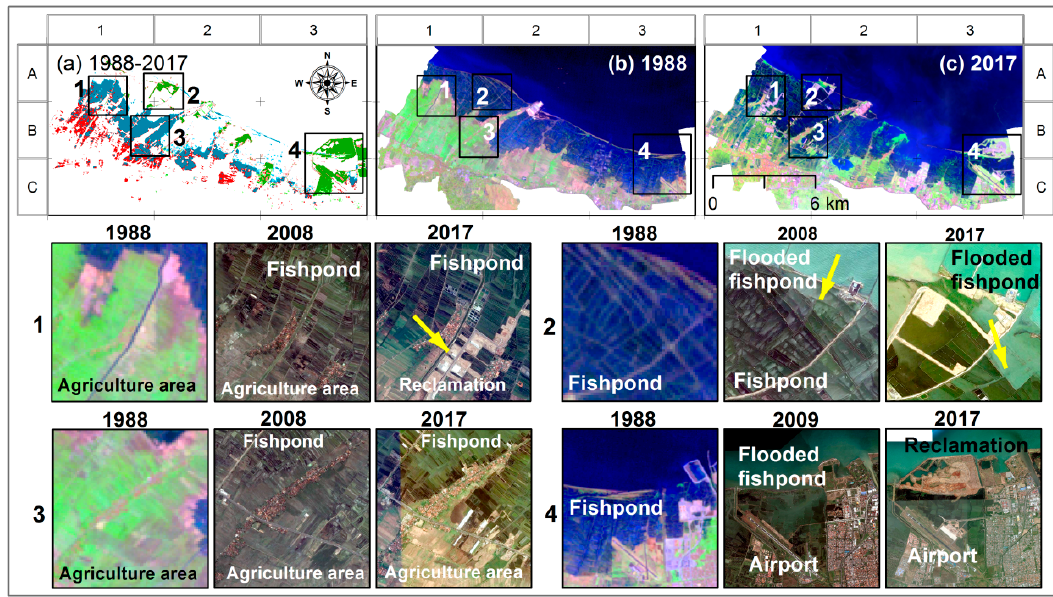
Figure 17. Changes of land use/cover observed in the west section. ( a ) Spatial distribution of changes from 1988 to 2017. Landsat images with RGB 542 from ( b ) 1988 and ( c ) 2017. Description of pixel colours can be seen in the caption of Figure 15. The four black boxes show zoomed-in areas. The 1988 Landsat and Google Earth images show the type of land use/cover in those areas. Agricultural areas, fishponds , mangroves , open water , and settlements were distinguished based on criteria described in the text.